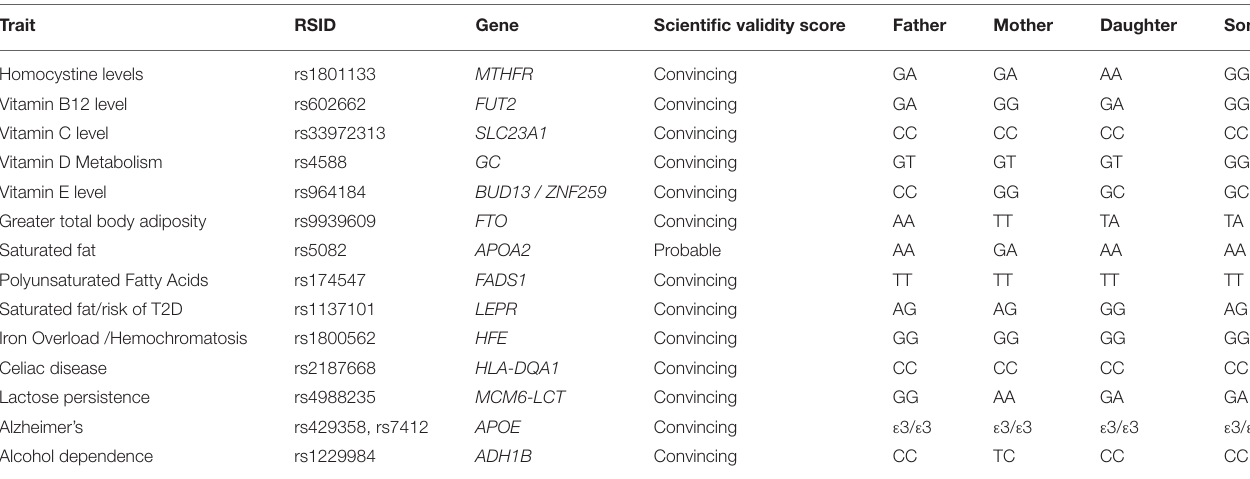
TABLE 7 | Summary of nutrition trait analysis for the 4 family